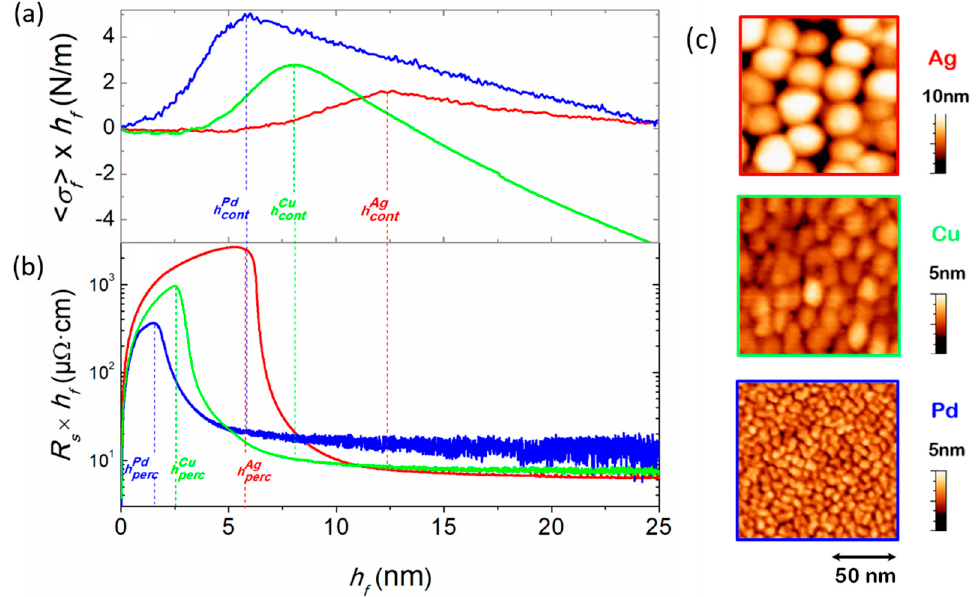
(cid:68) (cid:69) σ × h × h Figure 5. Real-time evolution of ( a ) Figure 5. Real-time evolution of ( a ) 〈𝜎 (cid:3033) 〉 × ℎ (cid:3033) and ( b ) 𝑅 (cid:3046) × ℎ (cid:3033) vs. ℎ (cid:3033) for sputter-deposited Ag (red f f and ( b ) R s f vs. h f for sputter-deposited Ag (red solid line), Cu (green solid line) and Pd (blue solid line) films on SiO 2 at T = 300 K. Morphological solid line), Cu (green solid line) and Pd (blue solid line) films on SiO 2 at T = 300 K. Morphological transition thicknesses h perc and h cont are indicated on the respective curves with vertical dashed lines transition thicknesses ℎ (cid:3043)(cid:3032)(cid:3045)(cid:3030) and ℎ (cid:3030)(cid:3042)(cid:3041)(cid:3047) are indicated on the respective curves with vertical dashed of the same color. ( c ) Atomic force microscopy (tapping mode) images (125 × 125 nm 2 ) showing the lines of the same color. ( c ) Atomic force microscopy (tapping mode) images (125 × 125 nm 2 ) showing surface morphology of Ag, Cu and Pd films with h f ~3 nm. More information on the growth conditions the surface morphology of Ag, Cu and Pd films with ℎ (cid:3033) ~3 nm. More information on the growth for each data set is provided in Table 1. Data taken from conditions for each data set is provided in Table 1. Data taken from [71,78]. Table 1. Deposition conditions and characteristic morphological transition thicknesses for Ag, Cu and Pd films deposited by magnetron sputtering at T = 300 K on SiO 2 . The Ar working pressure is 0.3 Pa.